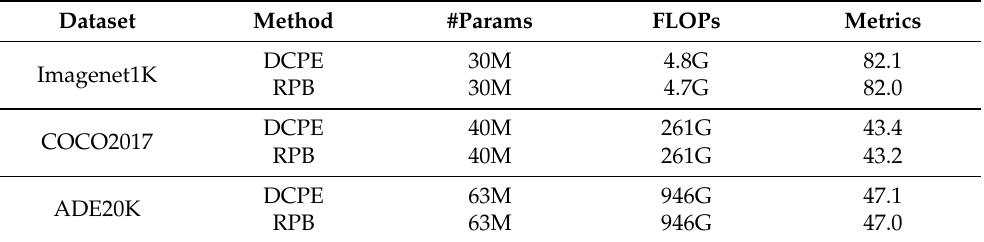
Table 8. Effectiveness of the proposed dynamic contextual positional encoding mode. Metrics on Imagenet1K is top-1 accuracy, on COCO2017 is AP b , and on ADE20K is